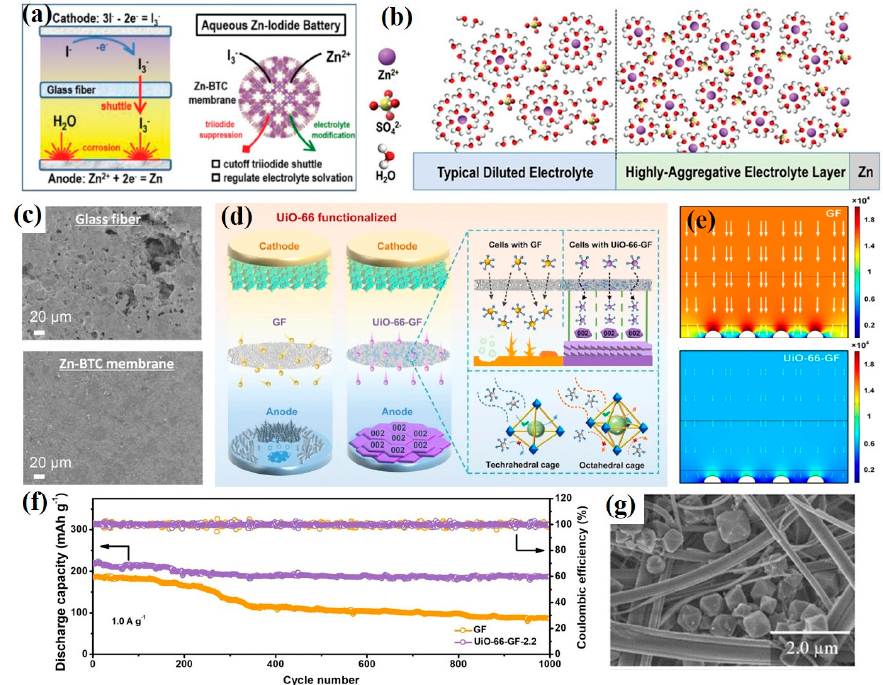
Figure 9. ( a ) Schematic illustration of Zn–I 2 batteries with glass fiber (GF) separator and Zn-BTC membrane. ( b ) Solvation structure of typical diluted ZnSO 4 solutions and high-aggregative electrolyte layer on Zn anode. ( c ) SEM images of Zn anode after cycling with GF separator and Zn-BTC membrane [81]. Copyright 2020, John Wiley and Sons. ( d ) Schematic illustration of AZIBs with UiO-66 functionalized glass fiber separator. ( e ) The electrical field models based on GF and UiO-66-GF separators. ( f ) Cycling performances and CEs of Zn|GF|MnO 2 and Zn|UiO-66-GF|MnO 2 cells at 1.0 A g − 1 [82]. Copyright 2022, Springer Nature. ( g ) SEM images of UiO-66 modified a glass microfiber separator [83]. Copyright 2022,